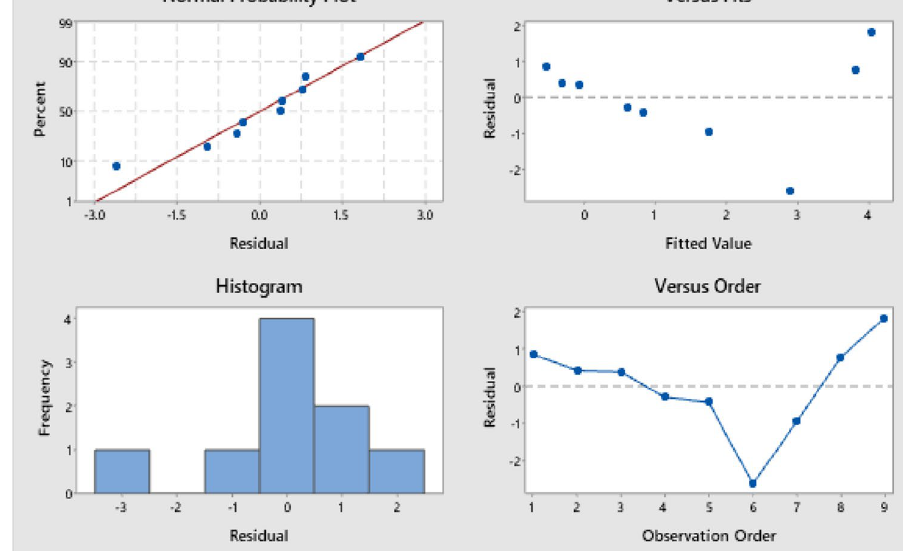
Fig. 19 Residual plot for CO with nanoparticles